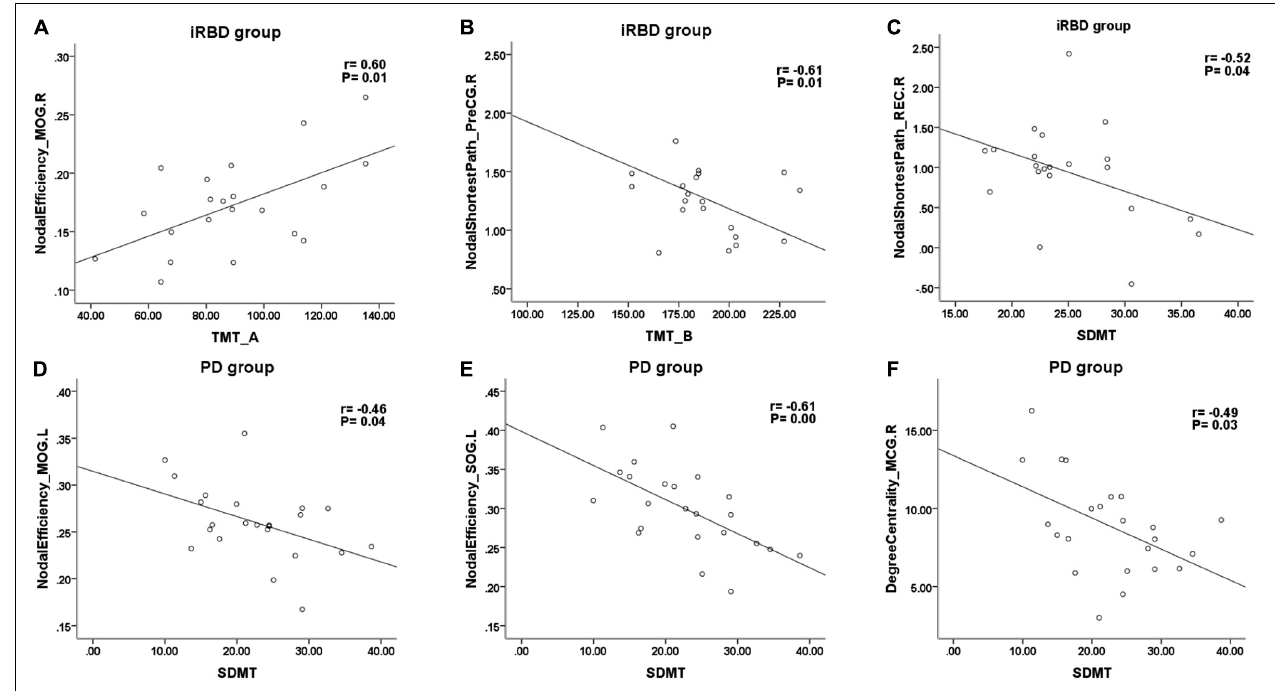
FIGURE 3 | Representative scatterplots between cognitive tests and local properties in iRBD and PD. SDMT, symbol digit modalities test; TMT-A, part A of trail making test; TMT-B, part B of trail making test; PreCG, precentral gyrus; REC, rectus gyrus; MOG, middle occipital gyrus; SOG, superior occipital gyrus; MCG, middle cingulate